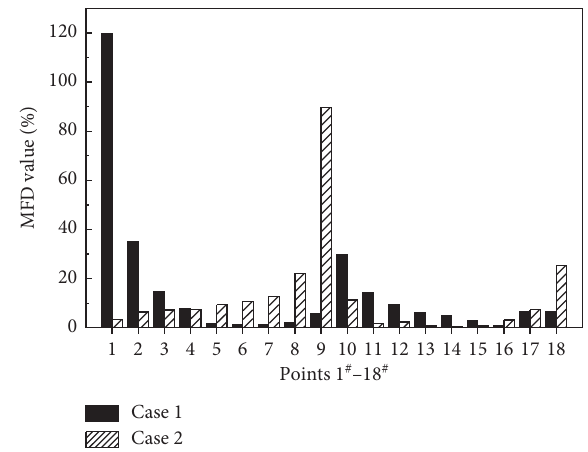
Figure 10: Relative difference of MFD in Case 1 and Case 2.